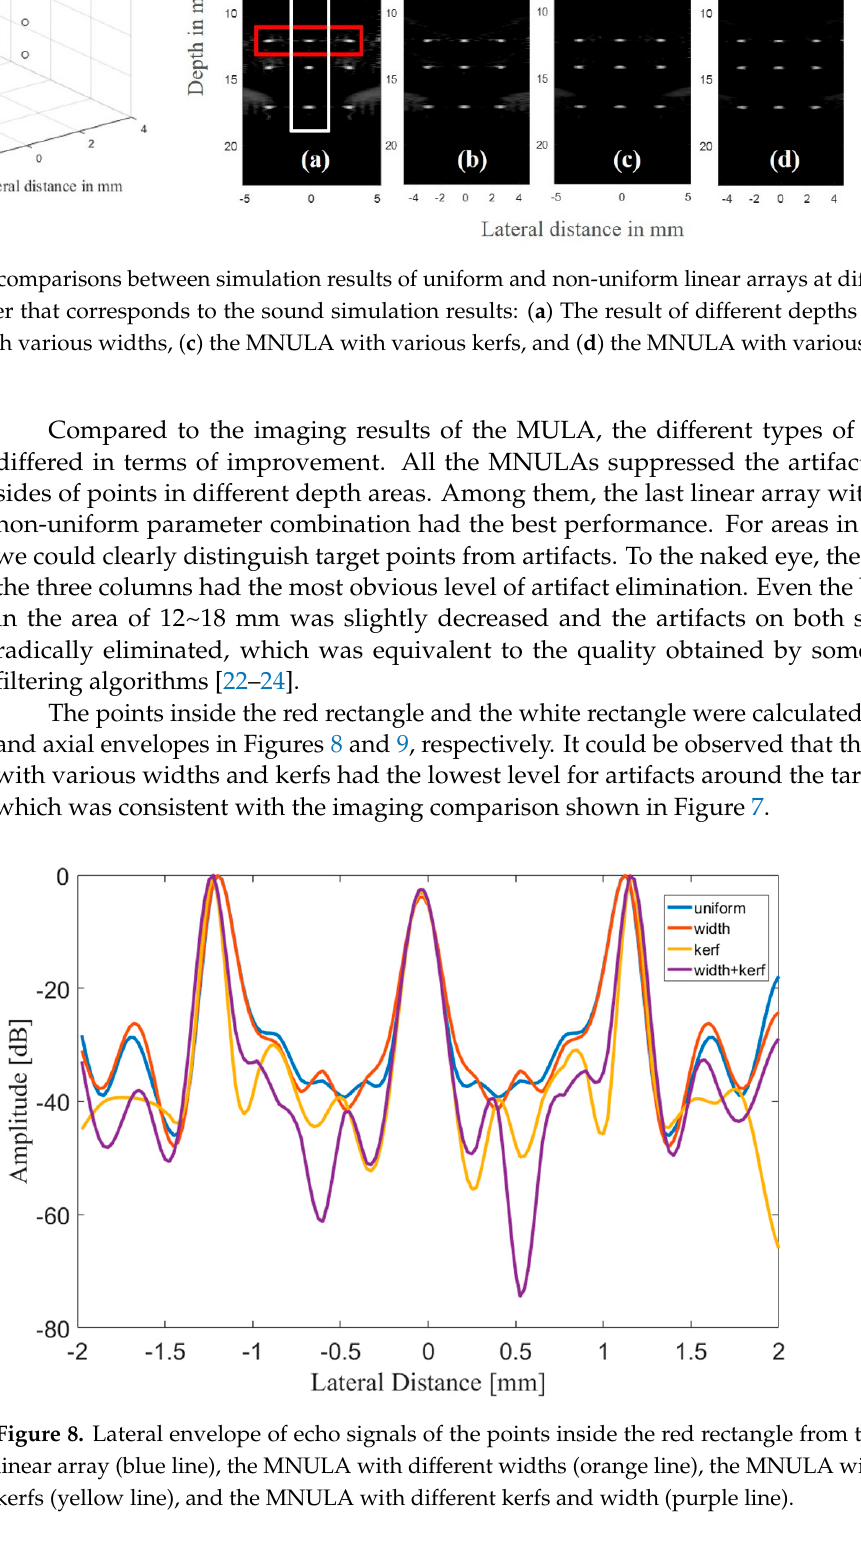
Figure 9. Axial envelope of echo signals of the point inside the white rectangle from uniform linear array (blue line), the MNULA with different widths (orange line), the MNULA with different kerfs (yellow line), and the MNULA with differ- ent kerfs and width (purple line). 3.2.3. Cyst Phantom The simulated cyst phantom consisted of three circle cysts lying in the tissue. The 4 mm-diameter cyst was at the depth of 5 mm, the 6 mm-diameter cyst was located at the depth of 13 mm, and the 7 mm-diameter cyst was at the depth of 21 mm. The simulation results of the cyst phantom are shown in Figure 8. For the micro linear array, the majority of artifacts appeared in the near field. In Figure 10a it can be seen that the artifacts distrib- uted in the near field of the MULA affected the observation of the phantom shape. The cysts located at the depths of 5 and 13 mm were much more affected than that located at 20 mm because the cyst at the depth of over 20 mm was in the far field and the MULA could get a clear outline of the it.